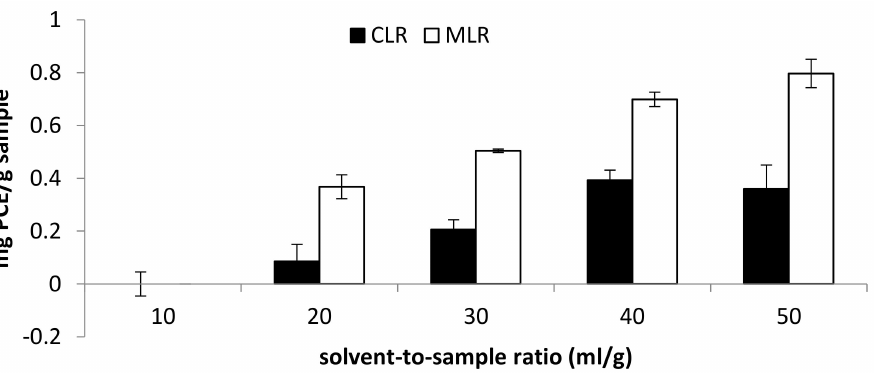
Figure 5. Effect of solvent-to-sample ratio on total flavonoid content